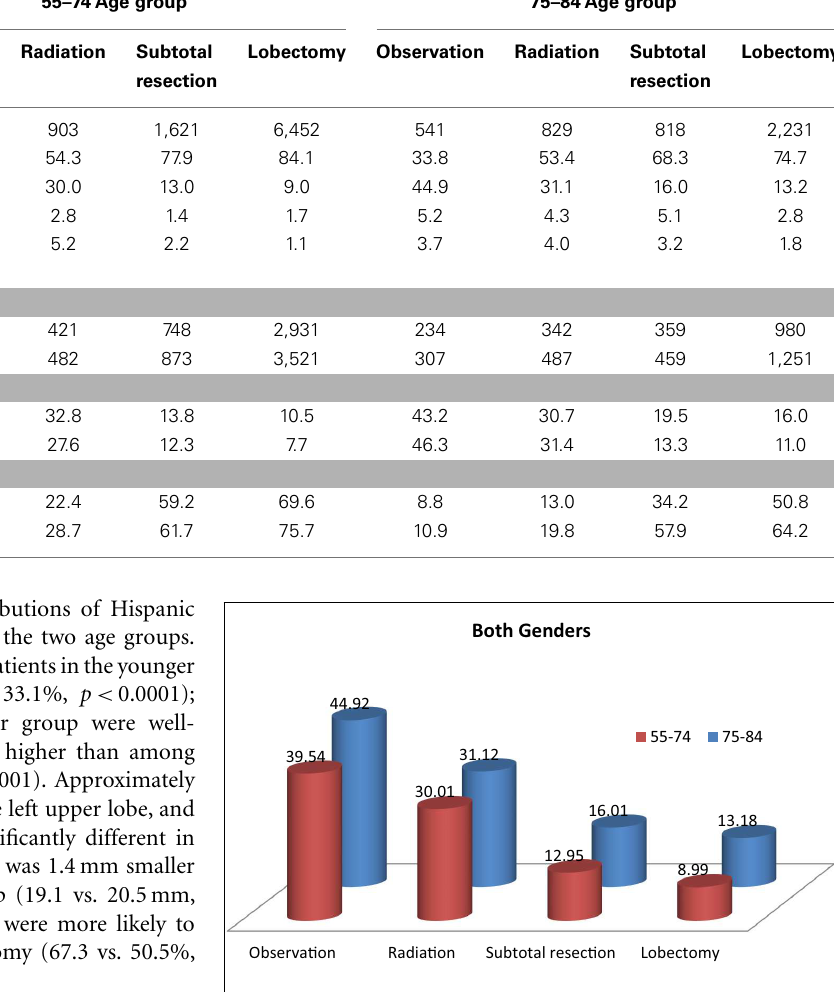
FIGURE 2 | Cause of death from lung cancer (crude) by treatment and age group (%): 2004–2009